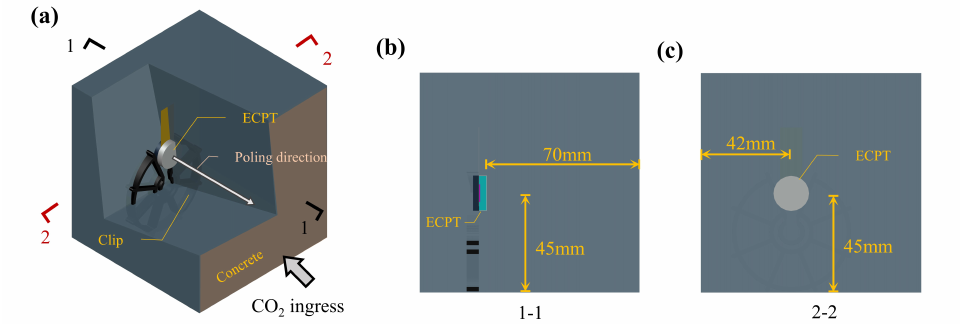
Figure 3. Arrangement of the embedded composite piezoelectric ultrasonic transducer: ( a ) partial cutaway perspective view of the specimen; ( b ) Section 1-1; ( c ) Section